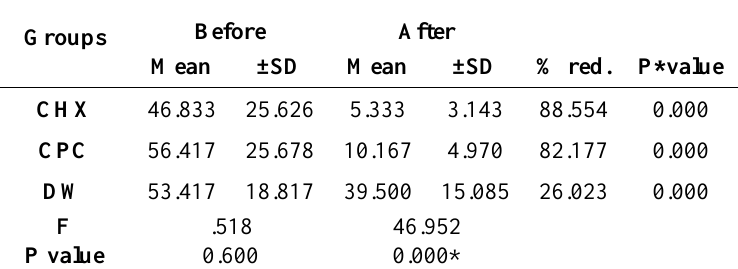
Table 5: Bacterial count mean and reduction among groups before and after rinsing in 12-inches location Groups Before